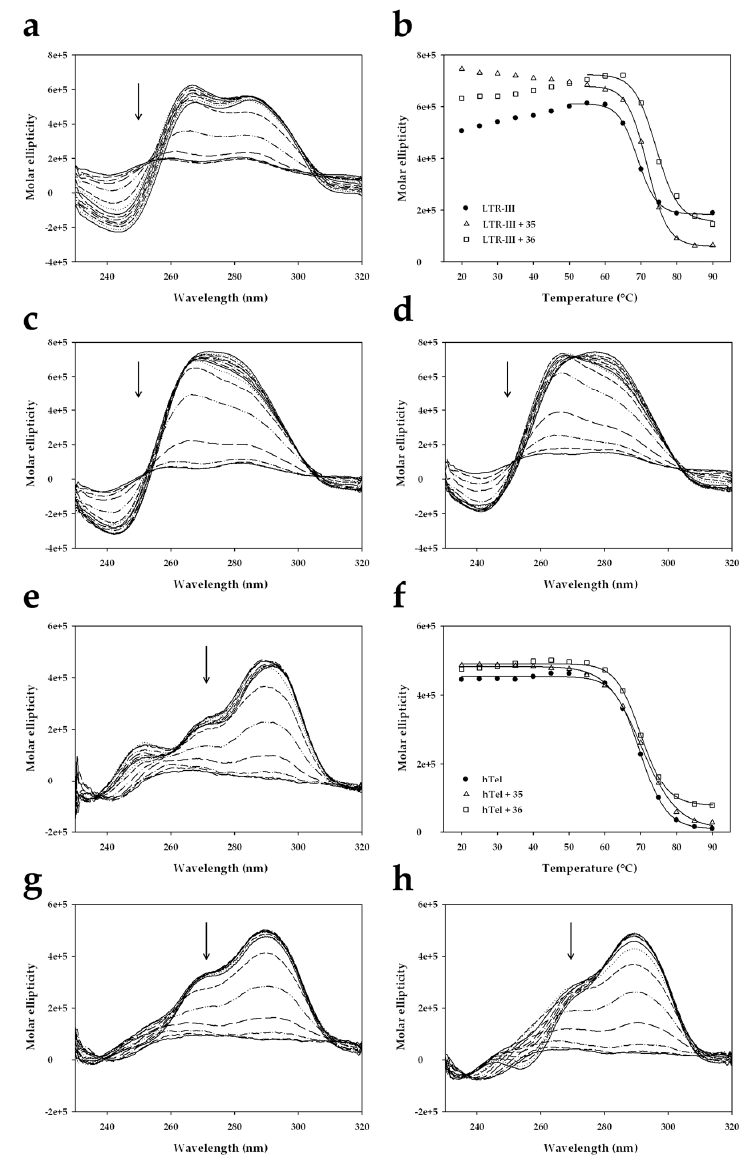
Figure 3. CD thermal unfolding analysis. CD of LTR-III G4 (1.5 μ M) at K + 100 mM in the absence ( a ) and in the presence of 10-fold excess of 35 ( c ) and 36 ( d ) (15 μ M). CD of hTel G4 (1.5 μ M) at K + 100 mM in the absence ( e ) and in the presence of 10-fold excess of 35 ( g ) and 36 ( h ) (15 μ M). CD spectra variation is shown as a function of the wavelength; arrows indicate the spectral change from low to high temperatures. The molar ellipticity at the peak wavelength (265 nm for LTR-III G4 ( b ) and 290 nm for hTel G4 ( f )) is shown as a function of the temperature.